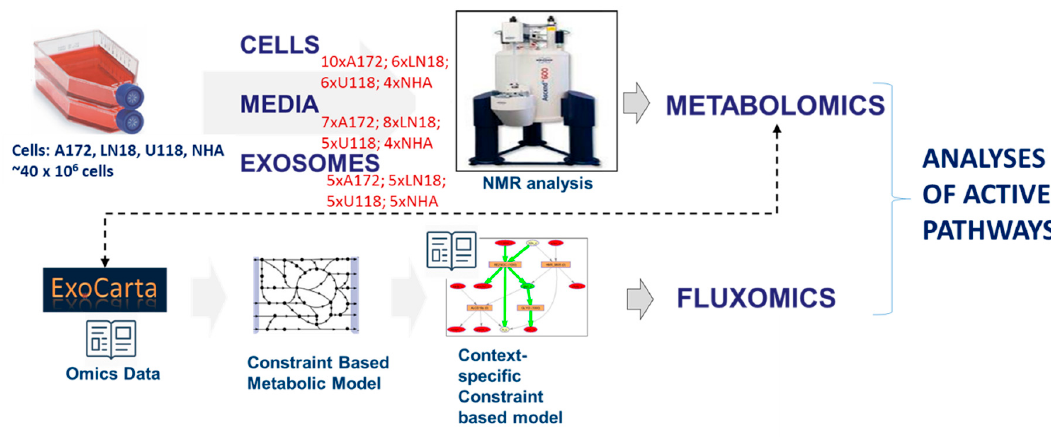
Figure 10. Experimental workflow of sample preparation for cells, media and EV analysis by NMR spectroscopy. Metabolomics, as well as computational flux simulation, allowed the investigation of possibly active pathways in EVs. Shown in red are the number of biological replicates measured for each cell and sample type.